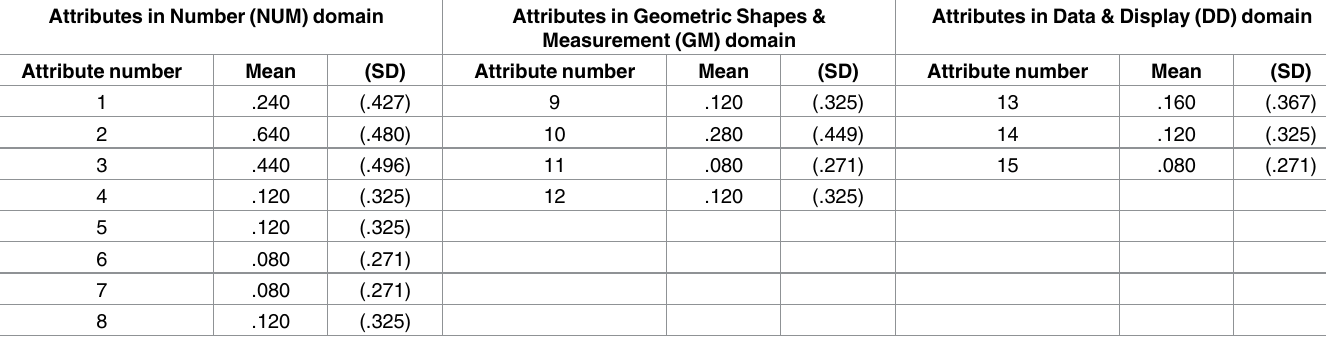
Table 3. Mean (SD) rate that each attribute is required for correctly answering items. Attributes in Number (NUM) domain Attributes in Geometric Shapes & Measurement (GM)